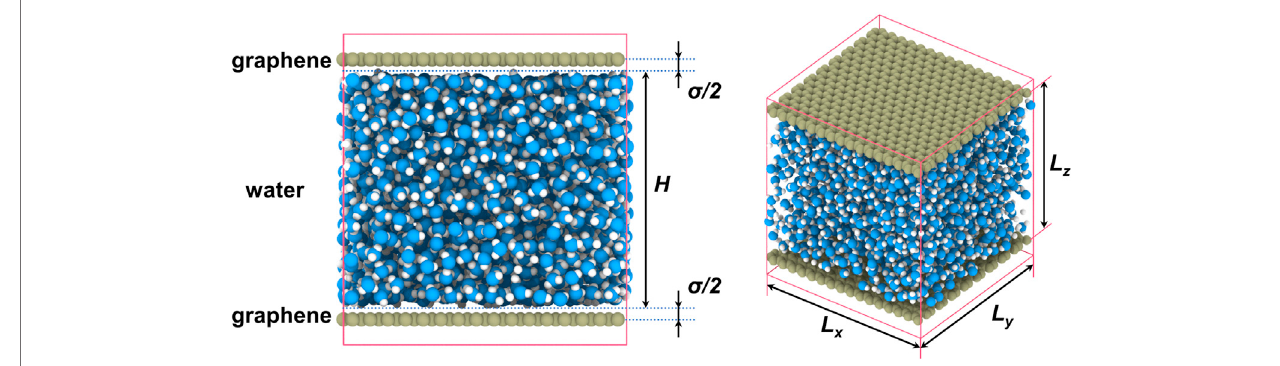
FIGURE 1 | Schematic of simulation system. Color codes: oxygen atom in blue, hydrogen atom in white, and carbon atom in